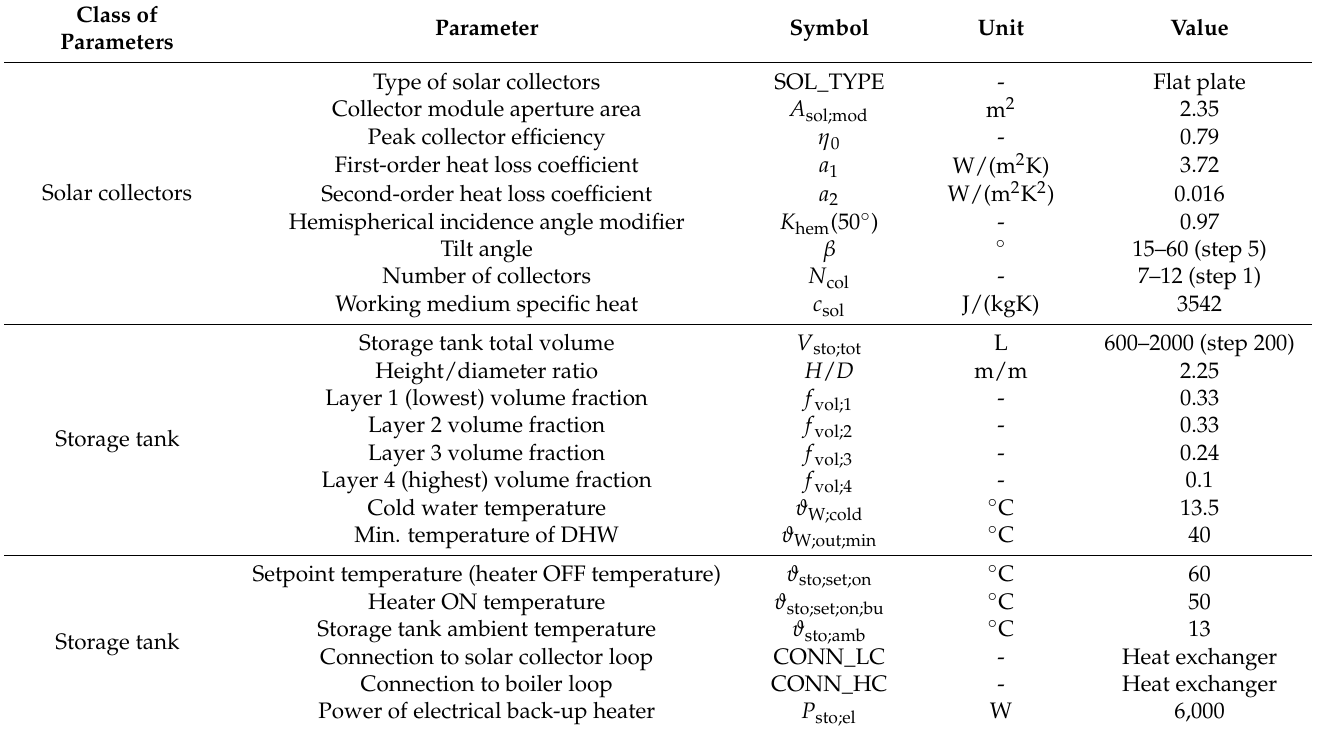
Table 5. Input data for calculation of solar collectors and storage tank.